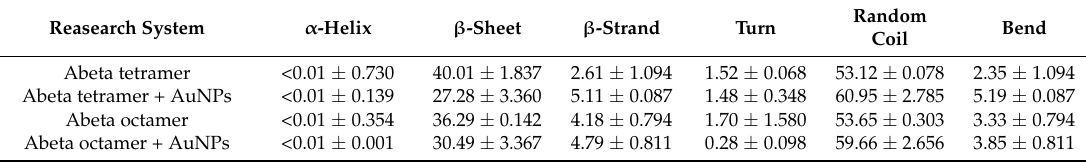
Table 1. Average secondary structure propensity of the A β (16-22) peptides with and without